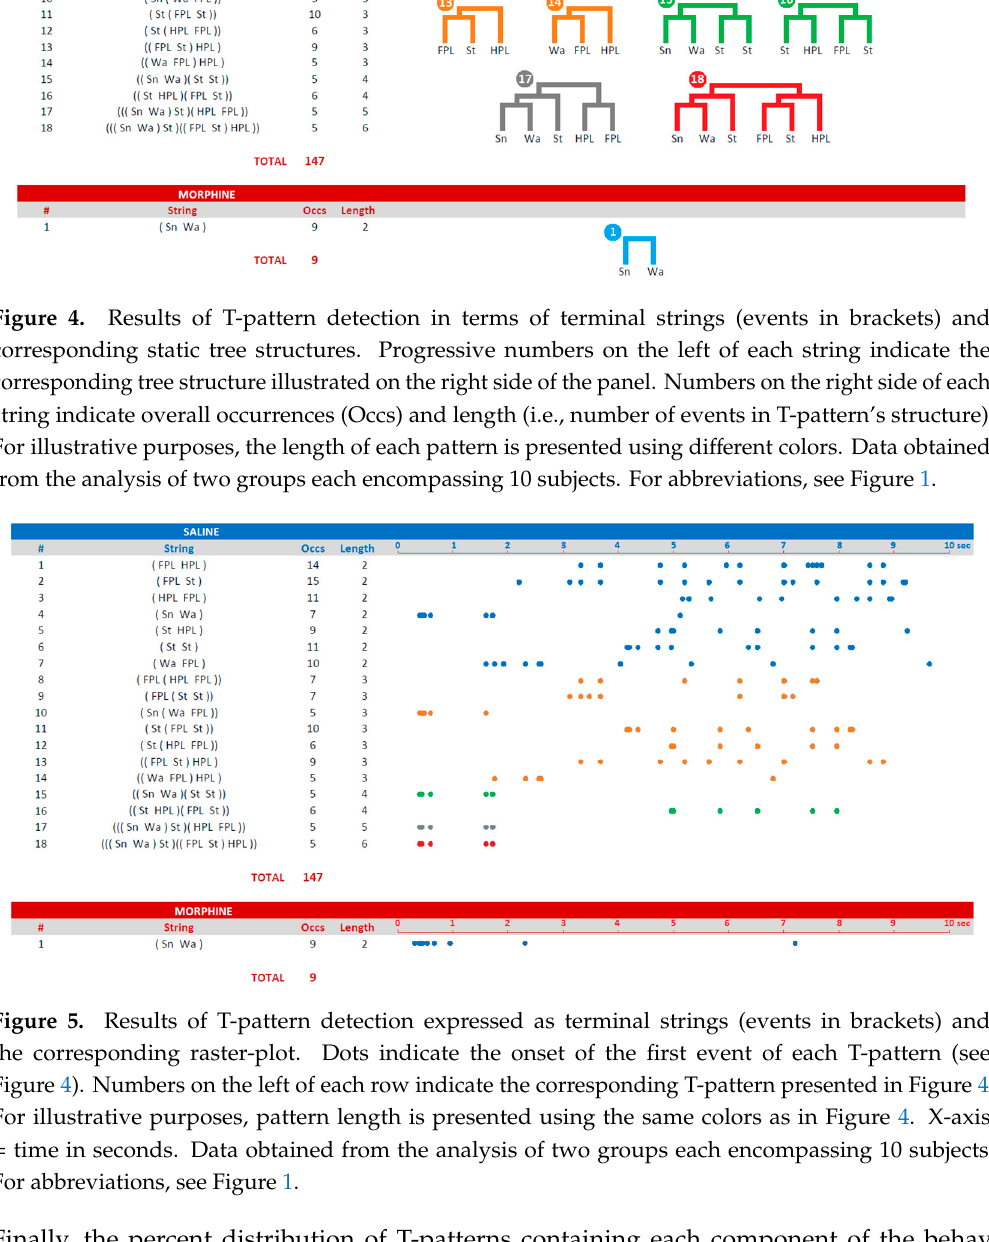
Figure 5. Results of T-pattern detection expressed as terminal strings (events in brackets) and the corresponding raster-plot. Dots indicate the onset of the first event of each T-pattern (see Figure 4). Numbers on the left of each row indicate the corresponding T-pattern presented in Figure 4. For illustrative purposes, pattern length is presented using the same colors as in Figure 4. X-axis = time in seconds. Data obtained from the analysis of two groups each encompassing 10 subjects. For abbreviations, see Figure 1.